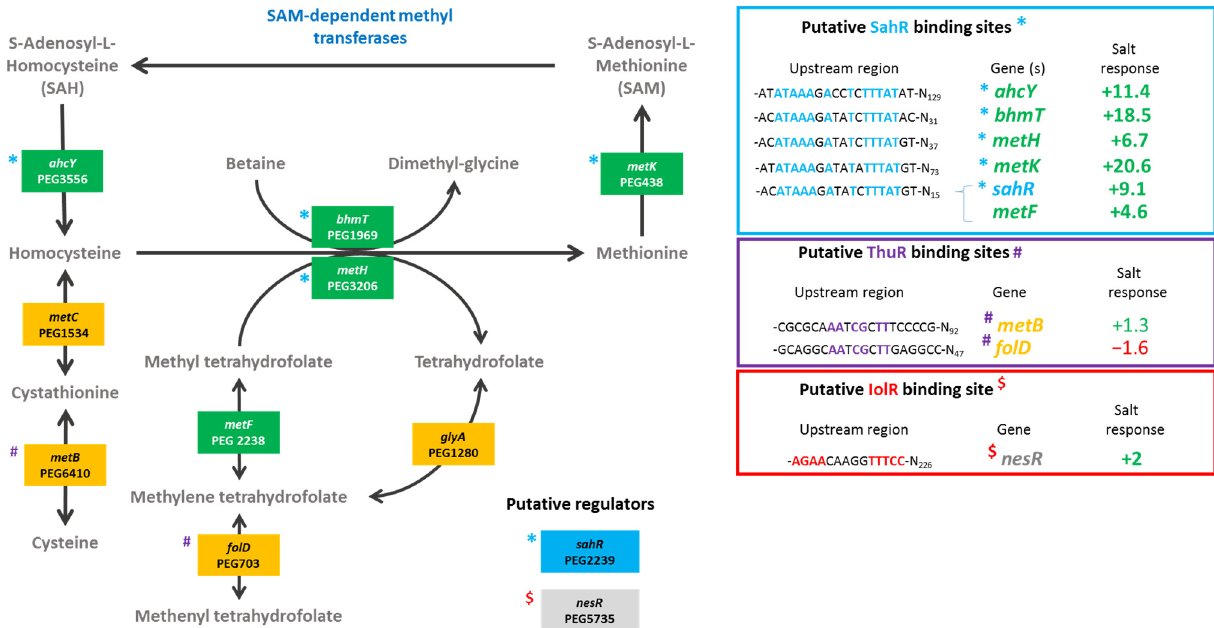
Figure 2. Metabolism of methionine. Ensifer aridi predicted encoding genes (PEGs) involved in the metabolism of methionine are shown in the metabolic pathway. The presence of putative SahR, ThuR, and IolR binding sites upstream of genes (shown in the right boxes) are indicated, respectively, by “*”, “#”, and “$” on the left of genes when identified, and the position of conserved residues are bolded and colored accordingly in boxes. The salt response refers to fold change previously found by RNAseq [15]. Positive fold changes indicating upregulation (green) and negative ones showing repression (red) in salt containing medium are bolded when above 2.